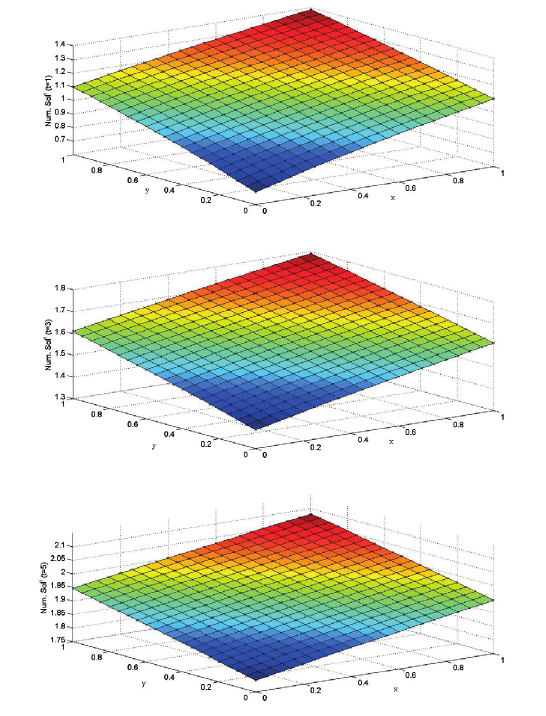
Fig. 7: Plots of numerical solution at different time levels for Exam- ple